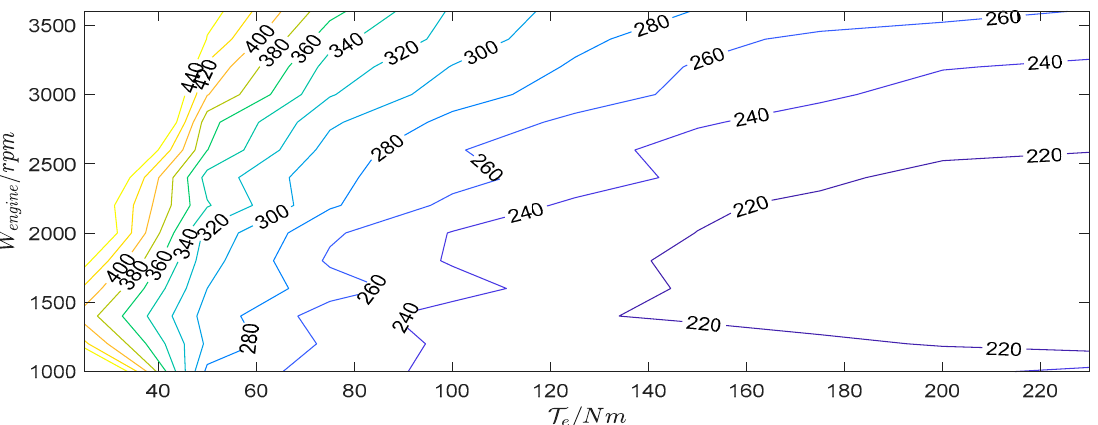
Figure 4. External characteristics of the CA4D28C5 diesel engine. The solid lines represent equal fuel consumption (g/kwh) contours.